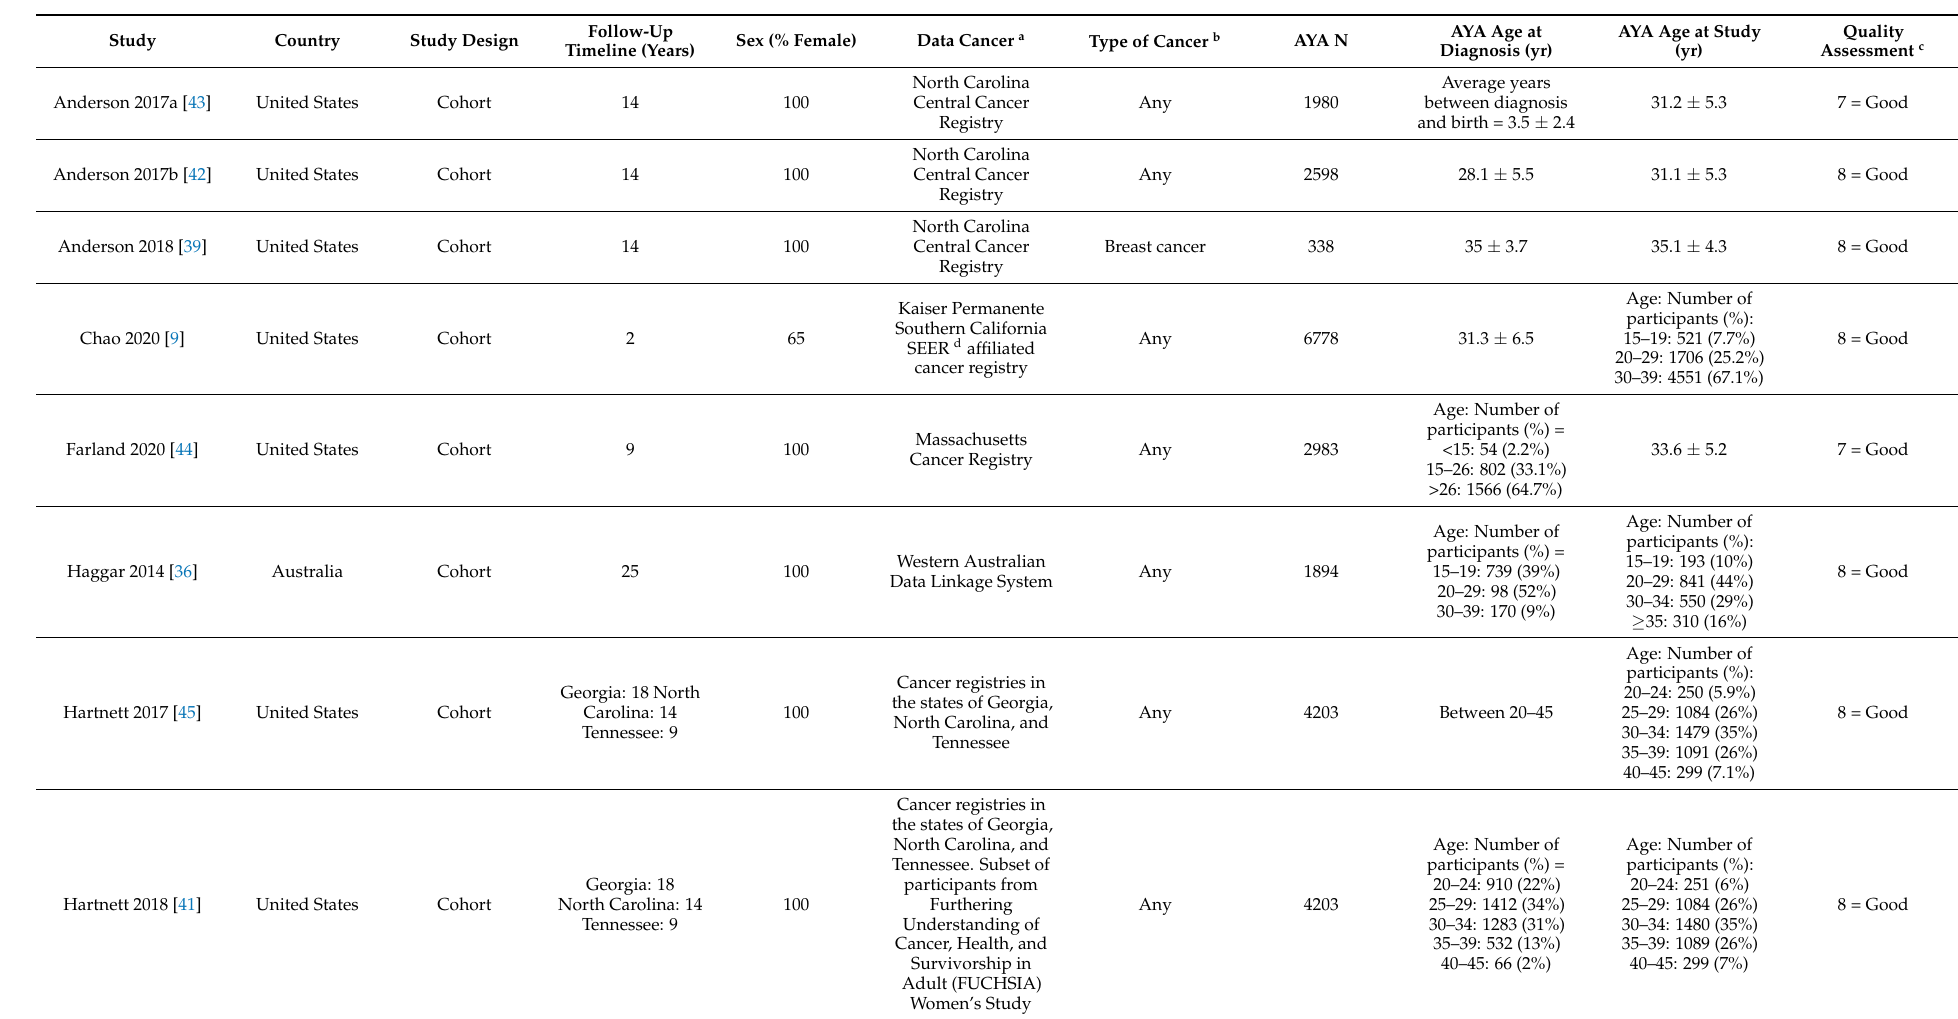
Table 3. Characteristics of included studies on reproductive health outcomes among adolescent and young adult (AYA) cancer patients (N =